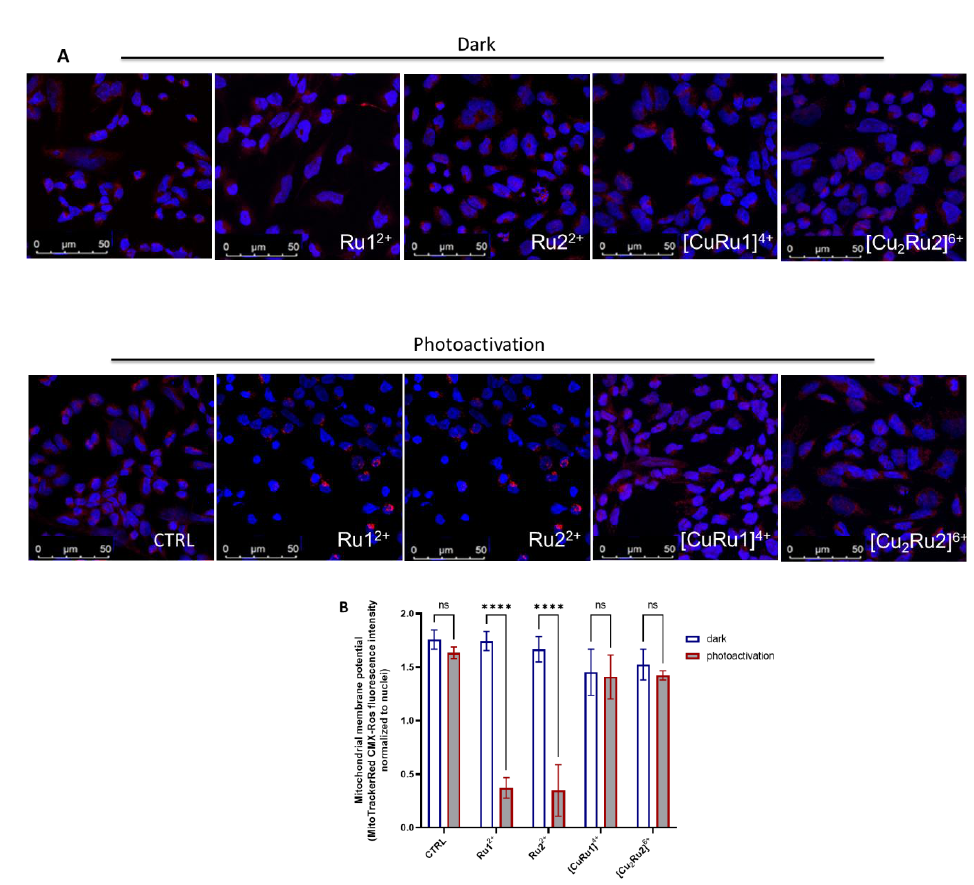
Figure 6. Effect of Ru(II) complexes on mitochondrial membrane potential after photoactivation.